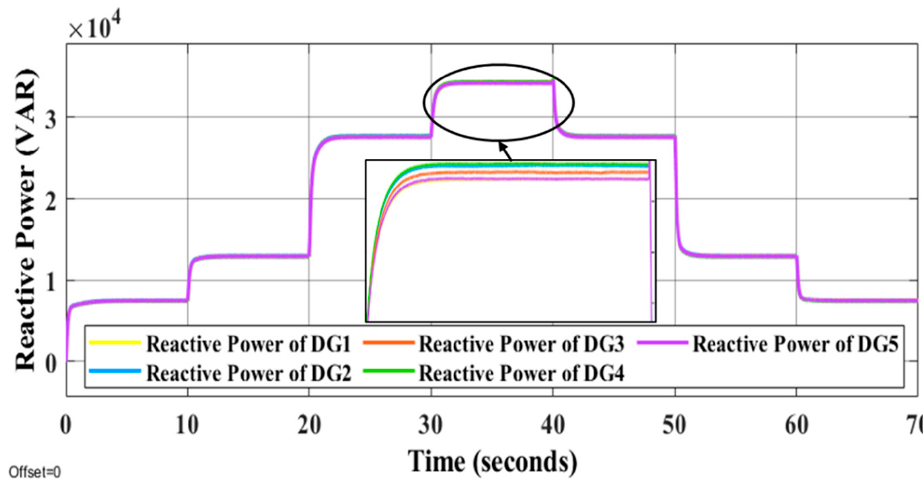
Figure 15. Reactive power of all DGs under the changing of load conditions.